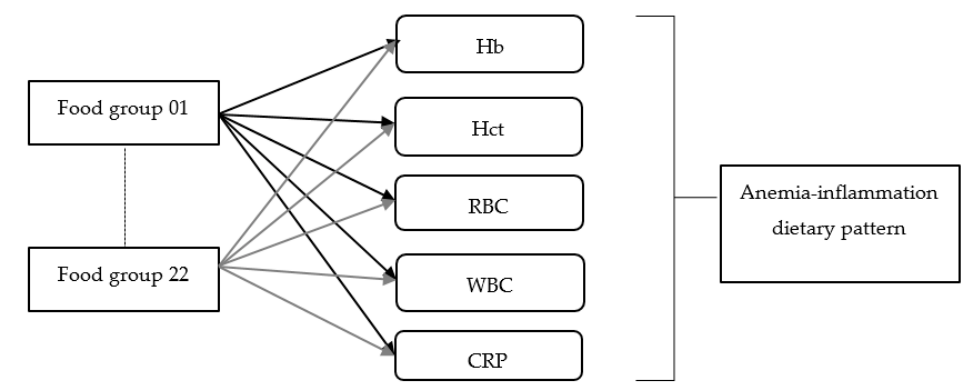
Figure 2. The dietary pattern derived from the reduced rank regression model. Hb: hemoglobin, Hct: hematocrit, RBC: red blood cells, WBC: white blood cells, CRP: C-reactive protein.